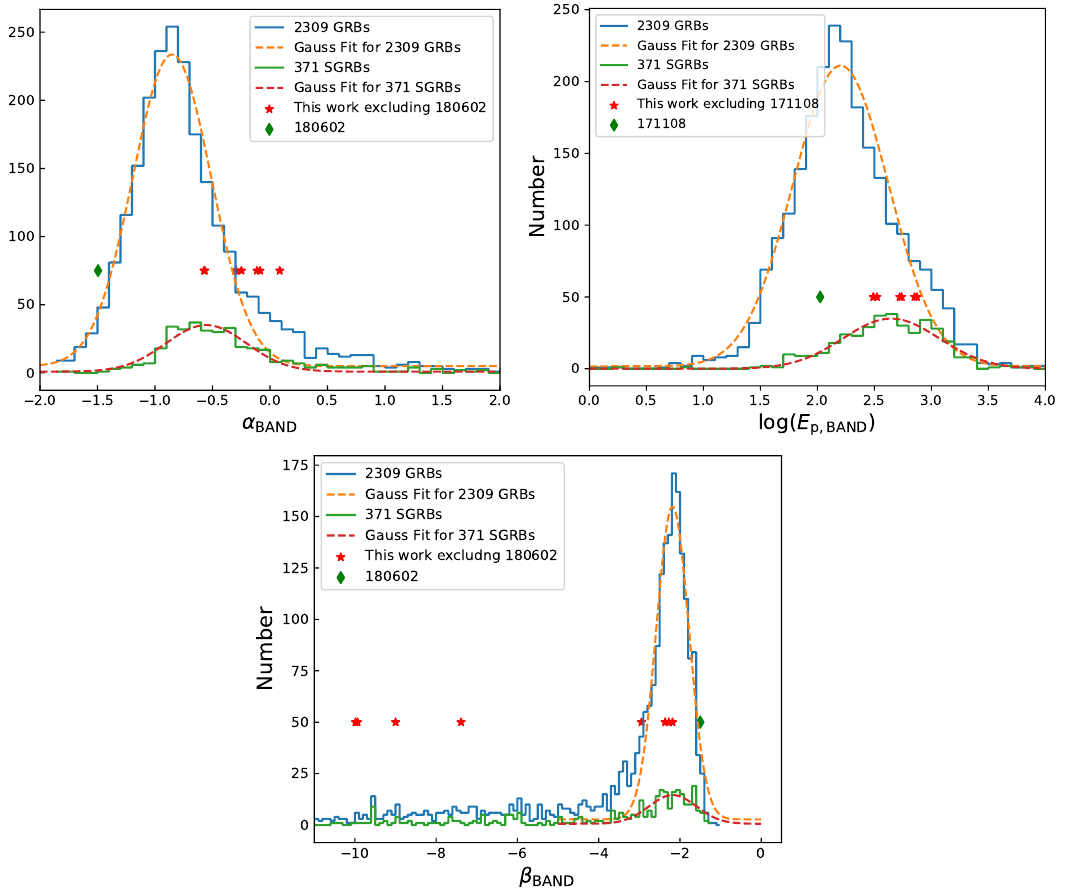
Figure 3. Same as Figure 2, but for the BAND model. ( Top Left ) α cata = − 0.85 ± 0.68, α SGRB = − 0.56 ± 0.70. ( Top Right ) E peak, cata = 10 2.20 ± 0.84 keV, E peak, SGRB = 10 2.65 ± 0.84 keV. ( Bottom ) β cata = − 2.18 ± 0.81, β SGRB = − 2.18 ±